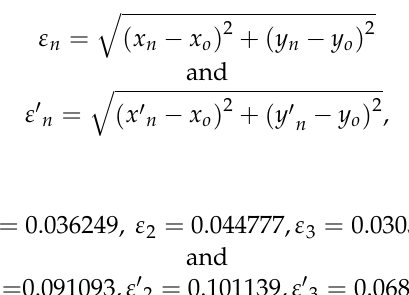
Figure 14. Comparison between IGSWF and SWF.